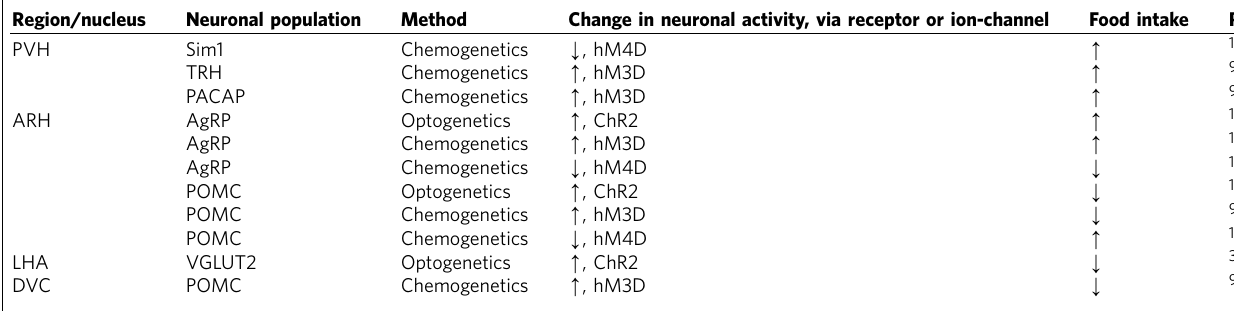
Table 2 | Cell type-specific manipulations reported to alter food intake.